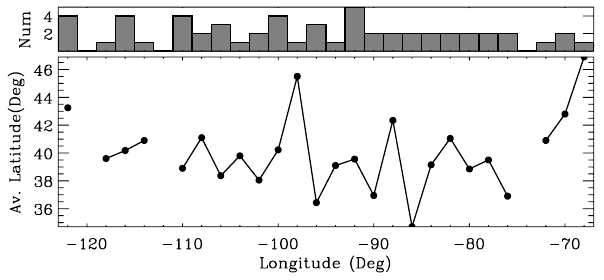
Fig. 6. Averaged latitude of each longitude bin (lower panel) and the station numbers in each bin (upper